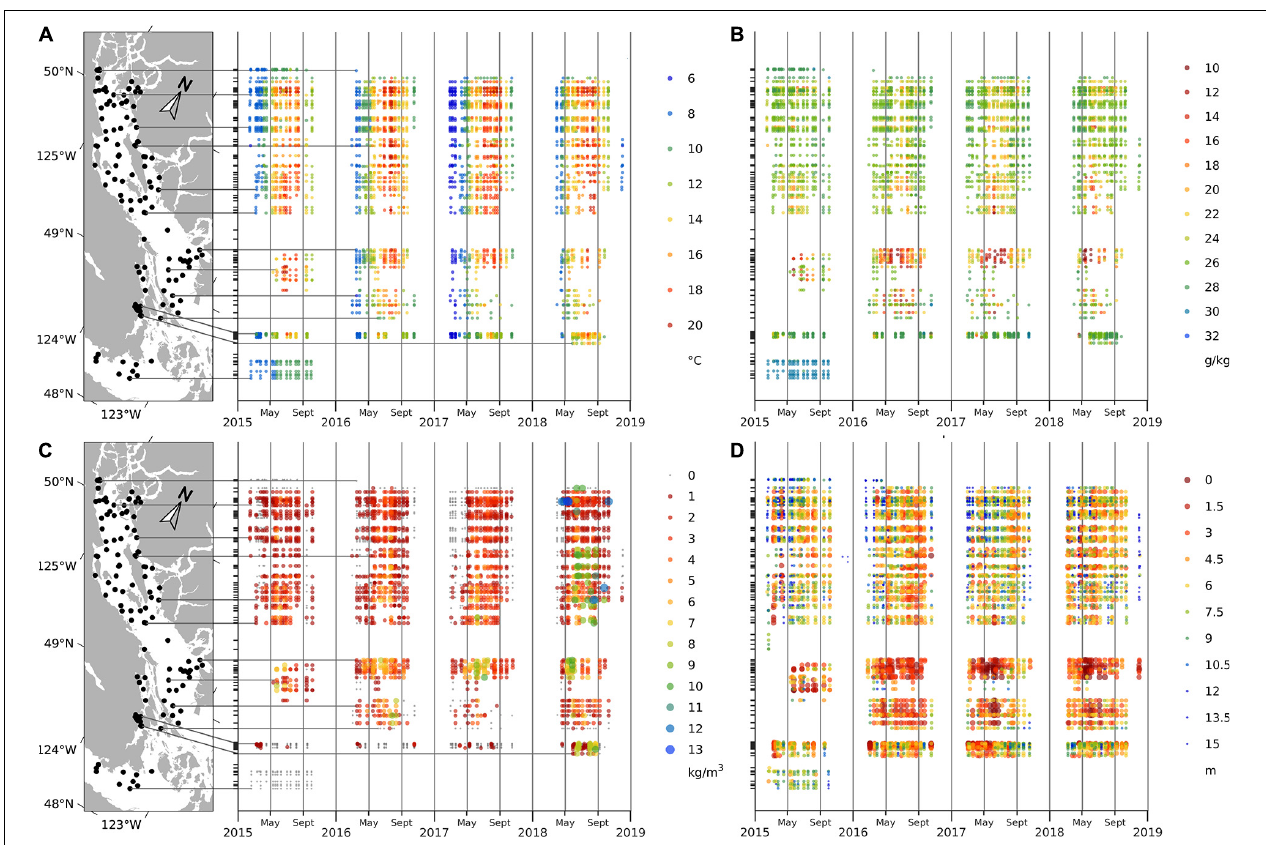
FIGURE 2 | Water temperature (A) and salinity (B) at 1 m, stratification parameter (C) and Secchi depth (D) in the Strait of Georgia.